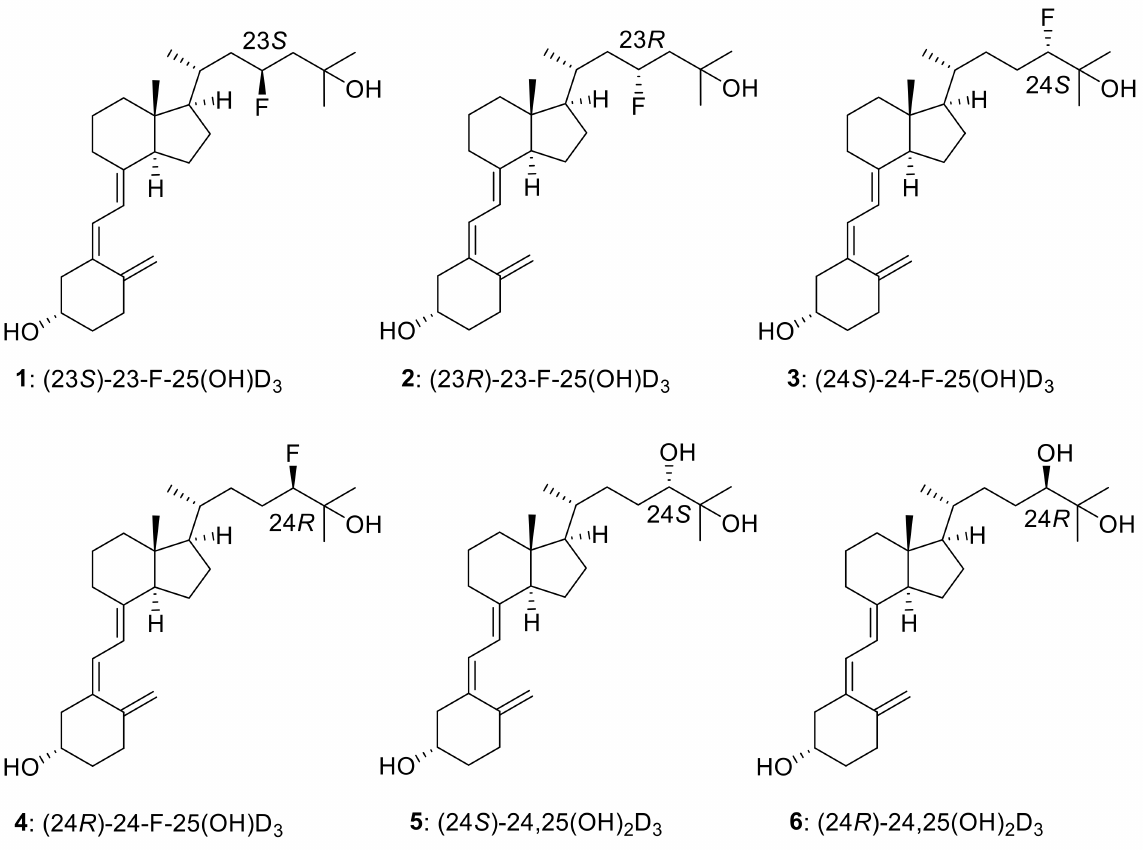
Figure 1. Structures of C23- and C24-substituted vitamin D 3